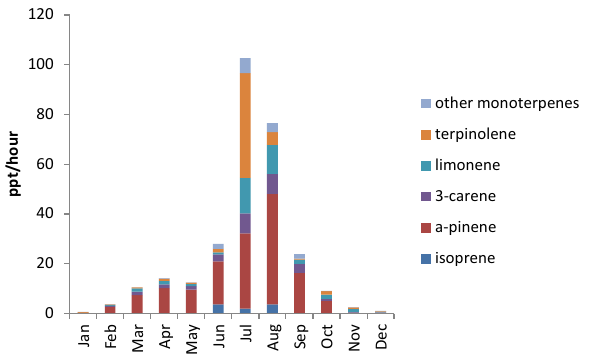
Fig. 11. Monthly means of destruction rates in reactions between ozone and the monoterpenes and isoprene.